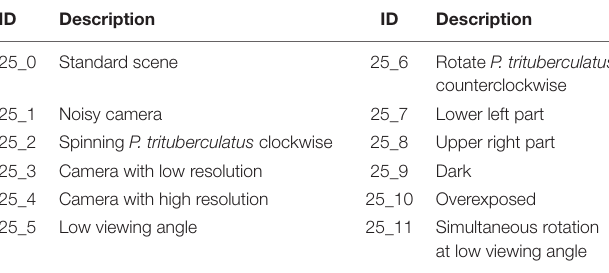
TABLE 1 | The scene description in practice.